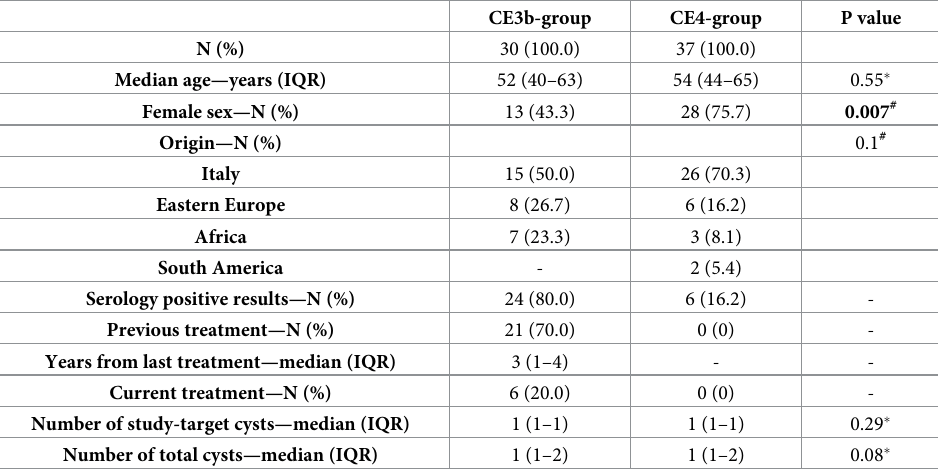
Table 1. Demographic and clinical characteristics of the enrolled